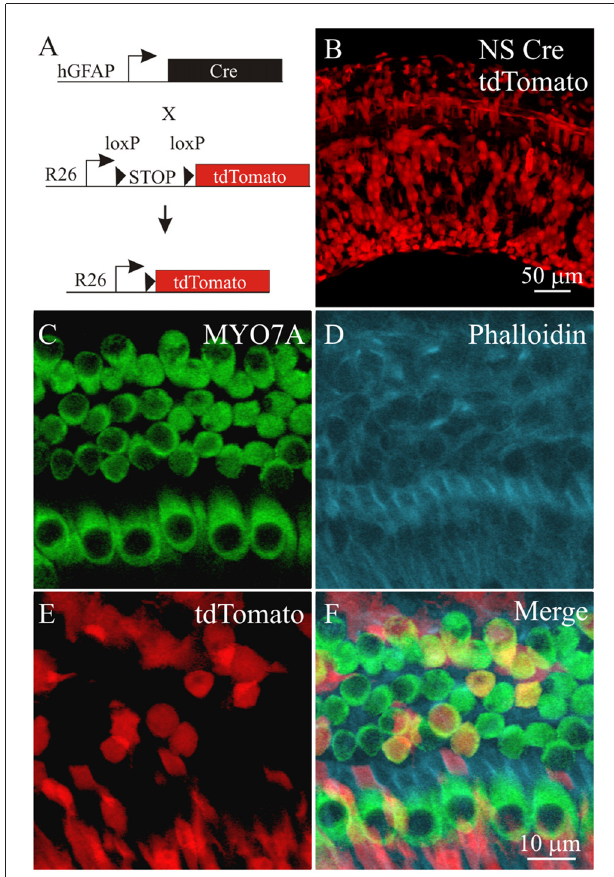
FIGURE 4 | Labeling cochlear cells using a neural subset (NS) Cre tdTomato reporter mouse. (A) Diagram of the NS Cre recombinase transgene using a fragment of the human GFAP (hGFAP) promoter driving Cre recombinase and a STOP floxed tdTomato reporter inserted in the ROSA26 (R26) locus. (B) tdTomato fluorescence from NS Cre tdTomato cochlea. Confocal section of the cochlear sensory epithelium labeled with (C) MYO7A, (D) phalloidin, (E) tdTomato from the NS Cre tdTomato reporter mouse. (F) Merged image ( n =